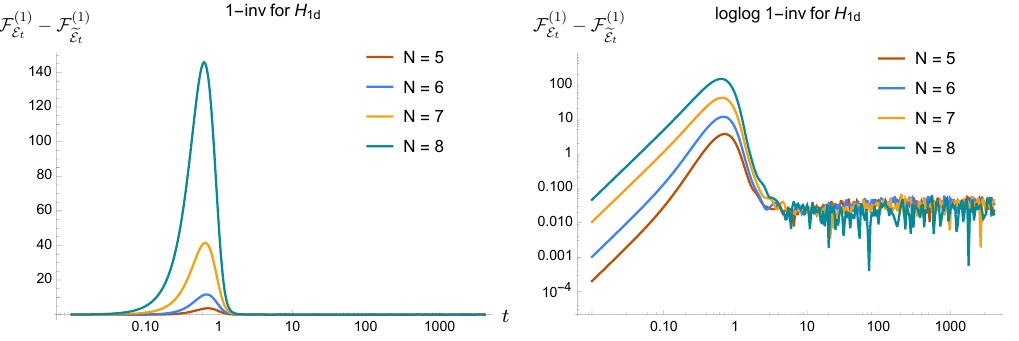
Figure 10 . Here we plot the unitary 1-invariance for the 1d local Hamiltonian in eq. (5.5) and observe a small value for the late time